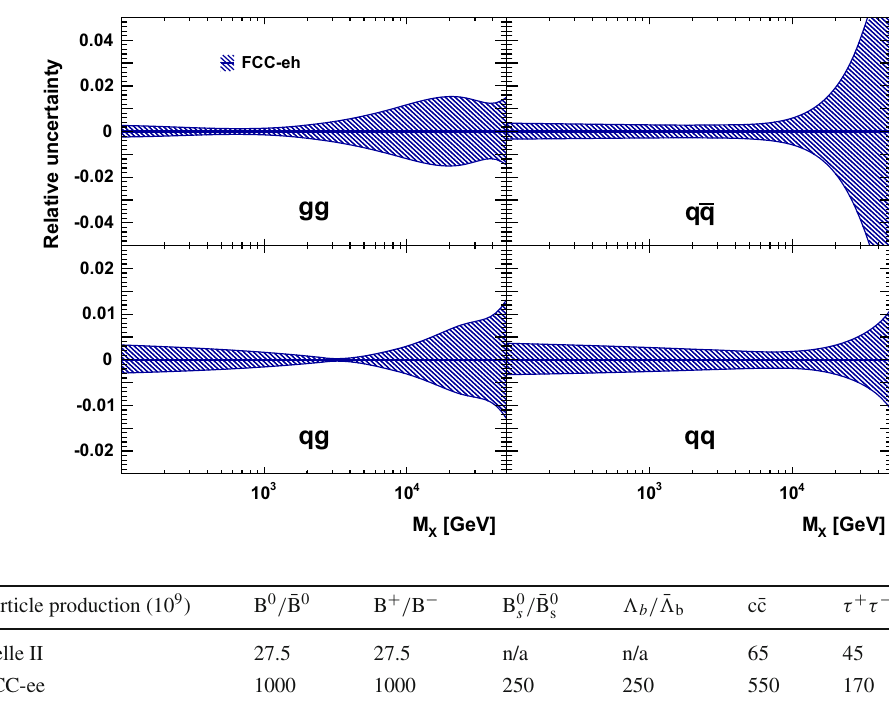
Fig. S.6 Left: total delay time for the QGP energy-loss parameter ˆ q = 4 GeV 2 / fm as a function of the top transverse momentum (black dots) and its standard deviation (error bars). The average contribution of each component is shown as a coloured stack band. The dashed line